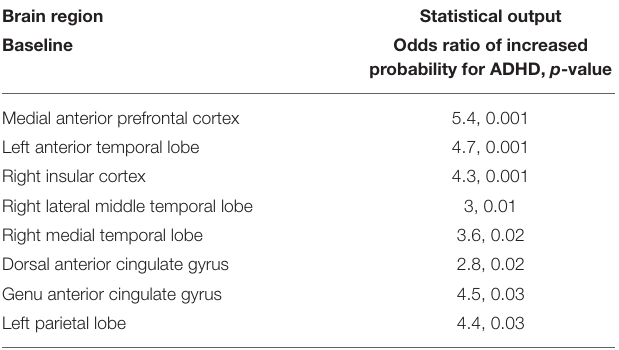
TABLE 2 | Predictive visually interpreted ROIs from Group 1. Brain region